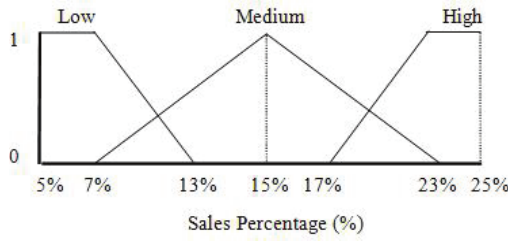
Fig. 5 Membership function for sales percentage in March for a decreasing discount rate campaign type and the interior paint product.